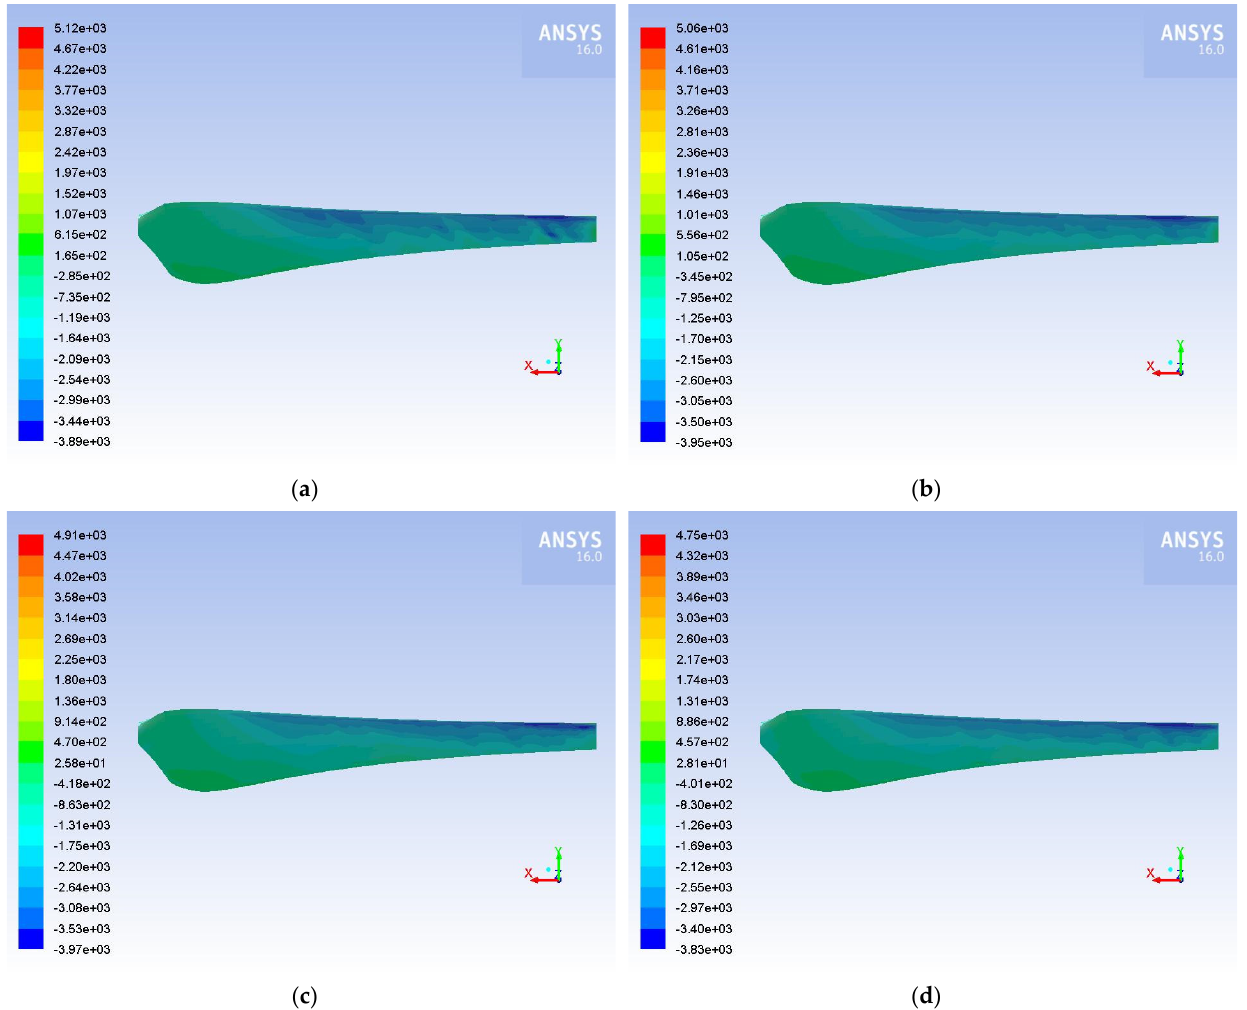
Figure 10. Static pressure contours at the blade’s suction side and at wind speed of 15 m · s − 1